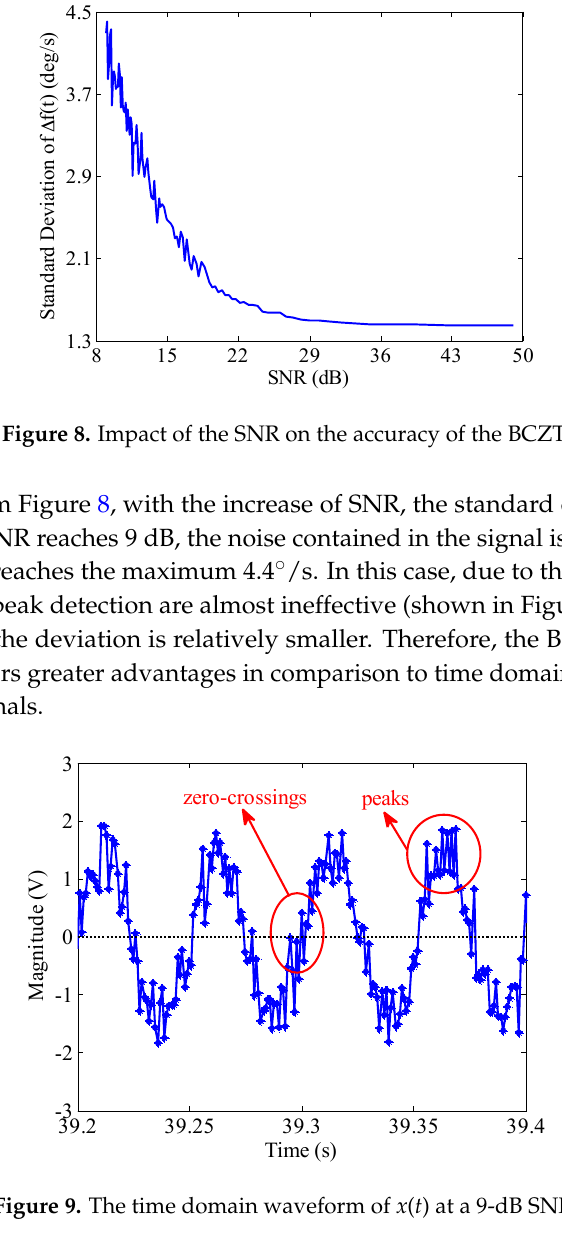
Figure 7. Impact of t M [ j ]’s position within the measurement window on the accuracy of the BCZT.